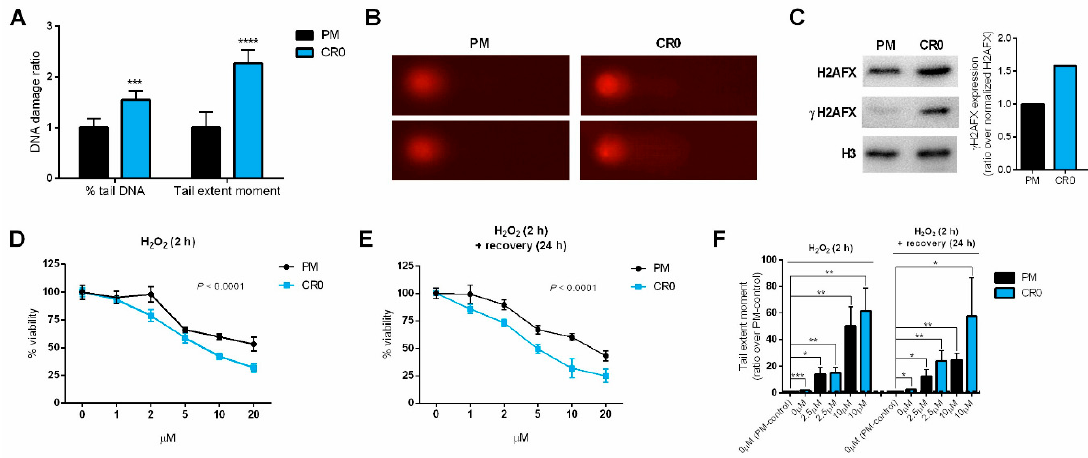
Figure 2. Evaluation of DNA damage and repair capacity in the post-chronic Cd-exposed cell line. ( A ) Intrinsic DNA damage level of CR0 cells (over PM control cells) was measured by comet assay ( n = 6); two DNA damage parameters, % tail DNA and tail extent moment, are shown. ( B ) Representative images of comet assay in PM and CR0 cells stained with 5 µ g / mL of propidium iodide after gel electrophoresis. ( C ) Expression of histone H2AFX and phosphorylated H2AFX ( γ H2AFX) were determined by Western blot (see Figure S2 for full blot). ( D , E ) Cell viability of PM and CR0 cells exposed to various concentrations of DNA damage-inducing agent H 2 O 2 for 2 h without or with a 24 h recovery period was measured by MTS assay; results were representative of at least three independent experiments, and error bars represent mean ± SD of at least three technical replicates. ( F ) Tail extent moment of PM and CR0 cells exposed to 0, 2.5, and 10 µ M of H 2 O 2 for 2 h without or with a 24 h recovery period was analyzed by comet assay. * p ≤ 0.05; ** p ≤ 0.01; *** p ≤ 0.001. 252